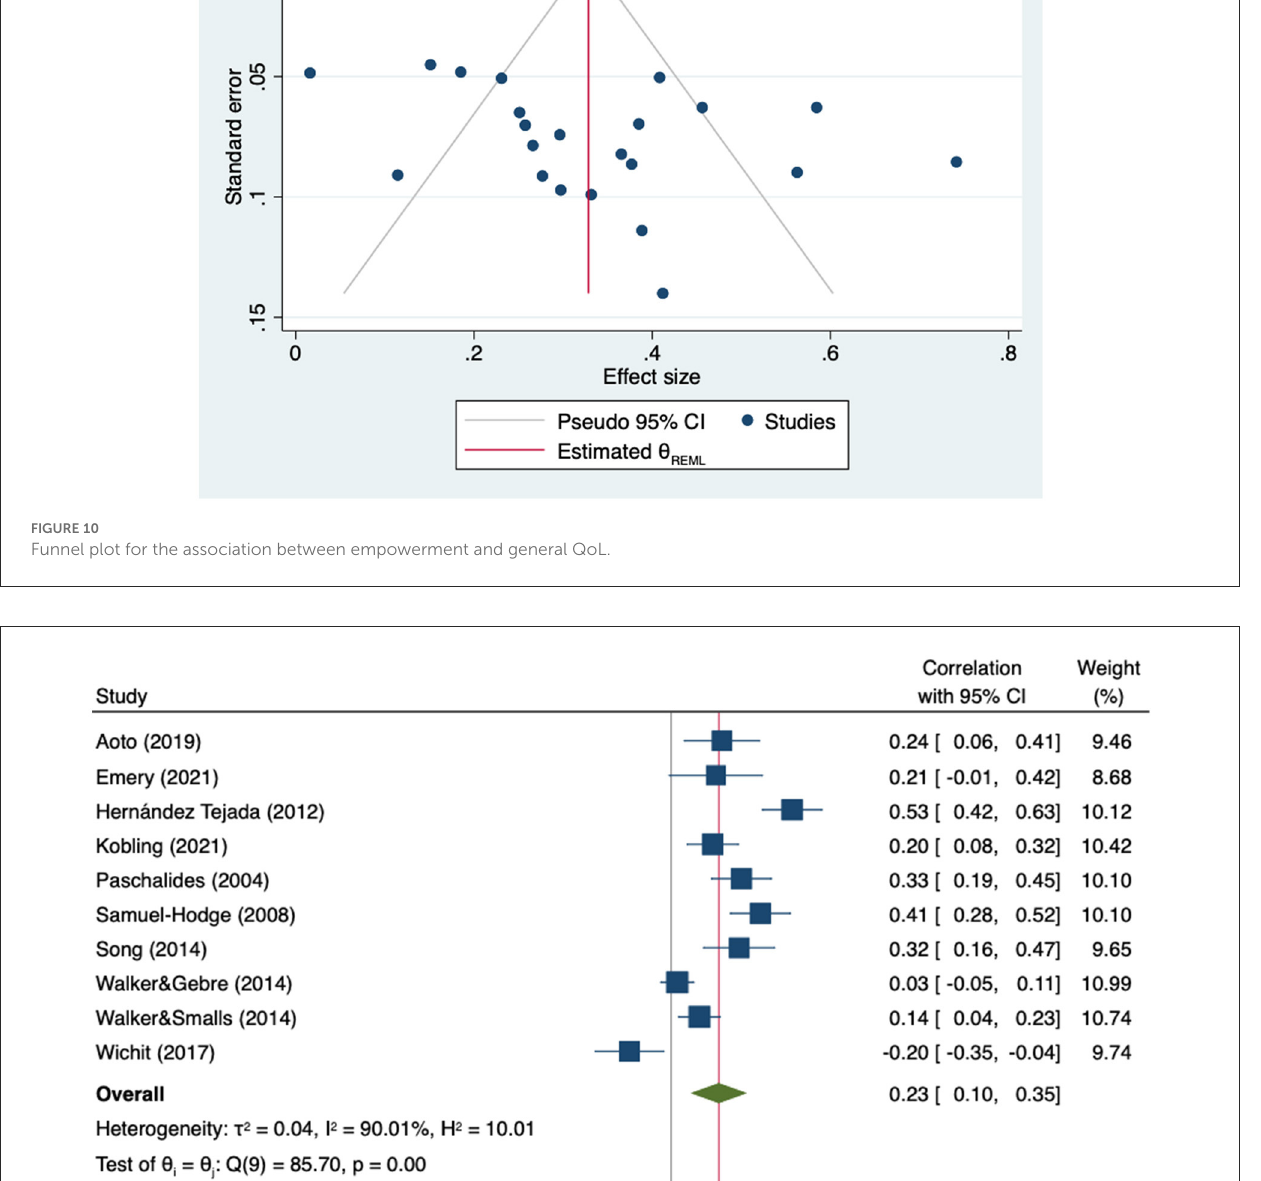
but not negligible. This evidence is mainly from cross- sectional studies and thus it is not possible to confirm the direction of the observed association. Consequently, high- quality prospective studies are warranted not only to better understand the role of patient empowerment and other